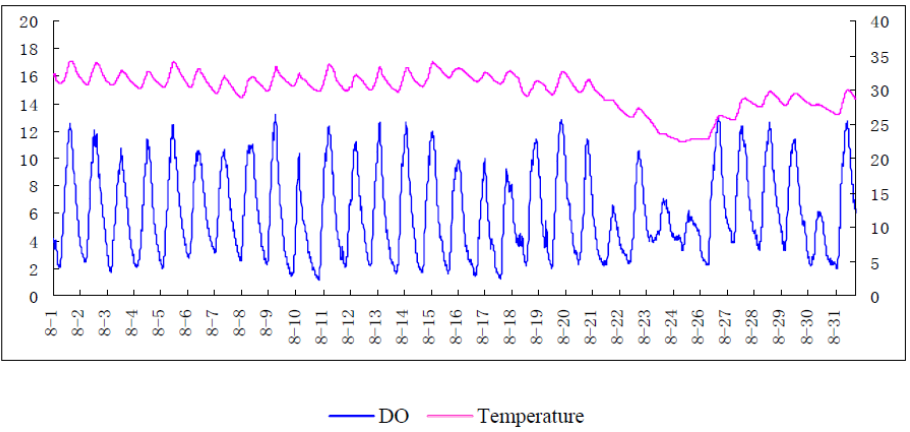
Figure 12. On-site Test.